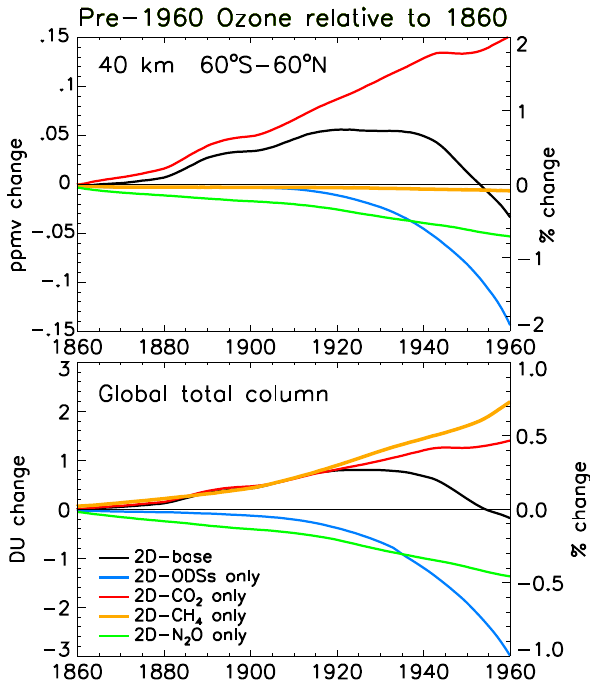
Fig. 8. Ozone time series for 1860–1960, relative to 1860 values, from 2-D model simulations for the 60 ◦ S–60 ◦ N average at 40 km (top), and the 90 ◦ S–90 ◦ N average total column (bottom). Shown are the base simulation (all source gases varied time dependently, black solid) and simulations in which only certain source gases are varied time dependently as follows: ODSs only (blue solid); CO 2 only (red solid); CH 4 only (orange solid); and N 2 O only (green solid), with the other source gases fixed at 1850 levels. Values are in Dobson Unit (DU) change (left axes) and % change (right axes).